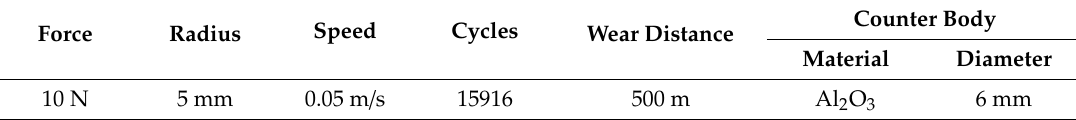
Table 4. Ball-on-disk test parameters.